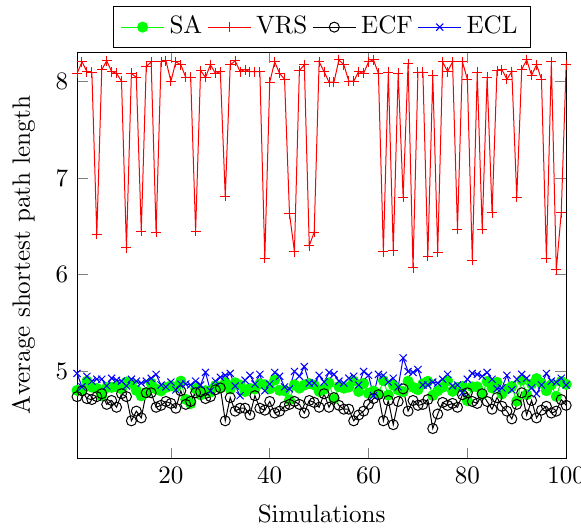
Figure 3. Average shortest path length (ASPL) of over 100 runs of SA, VRS, ECF, and ECL. The pro- posed ECF can generate topology with the lowest ASPL even with randomness.